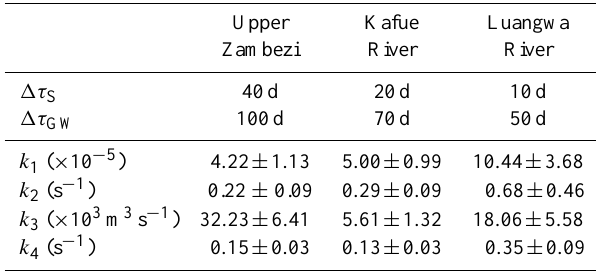
Table 1. Estimated parameters for the three sub-basins and the 95% confidence interval for each parameter.